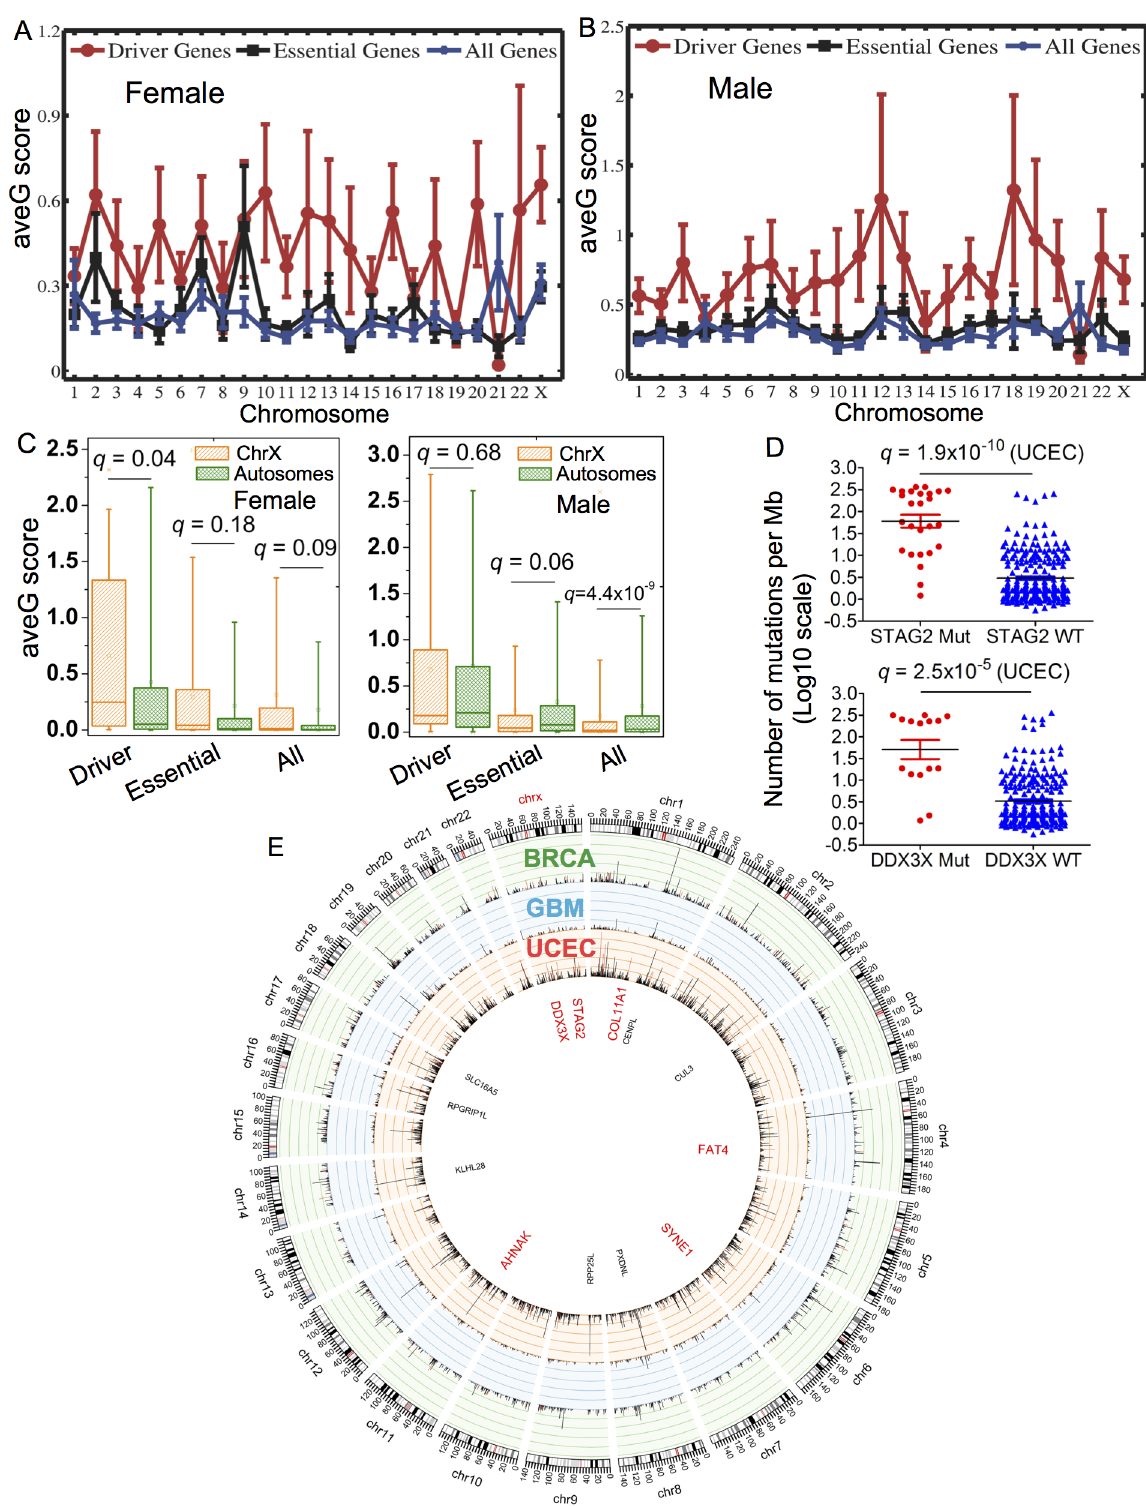
Fig 6. Distribution of average gravitation (ave G ) scores for cancer driver genes (Driver), essential genes (Essential), and all genes (All) in glioblastoma multiforme (GBM) male versus female genomes across 23 human chromosomes. The distribution of ave G scores for ( A ) GBM female genomes and ( B ) GBM male genomes. ( C ) Box plots show the comparison of aveG scores between the X chromosome (ChrX) and all the 22